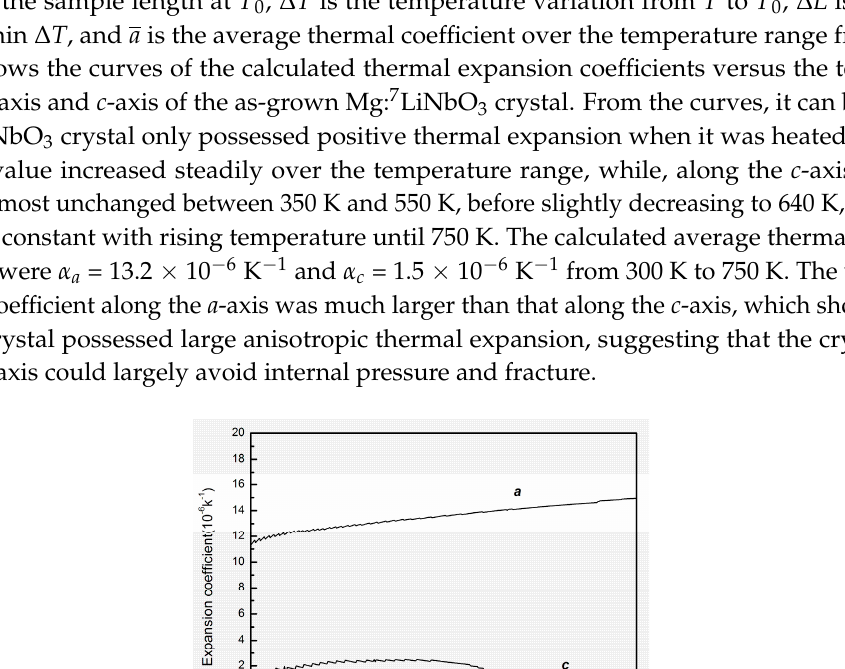
Figure 7. Thermal expansion coefficient curves along the a -axis and c -axis of the Mg: 7 LiNbO 3 crystal.